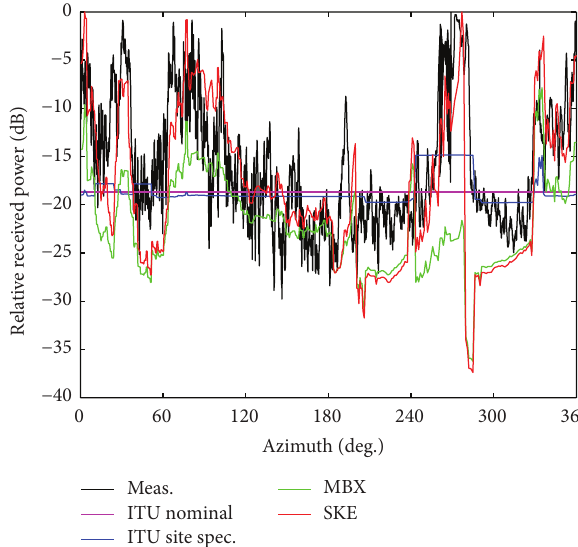
Figure 7: Scenario 3: a comparison of individual models: ITU-R P.452 nominal parameters (ITU nominal), ITU-R P.452 site-specific parameters (ITU site spec.), Maciel-Bertoni-Xia (MBX), Single knife-edge (SKE), and measured data